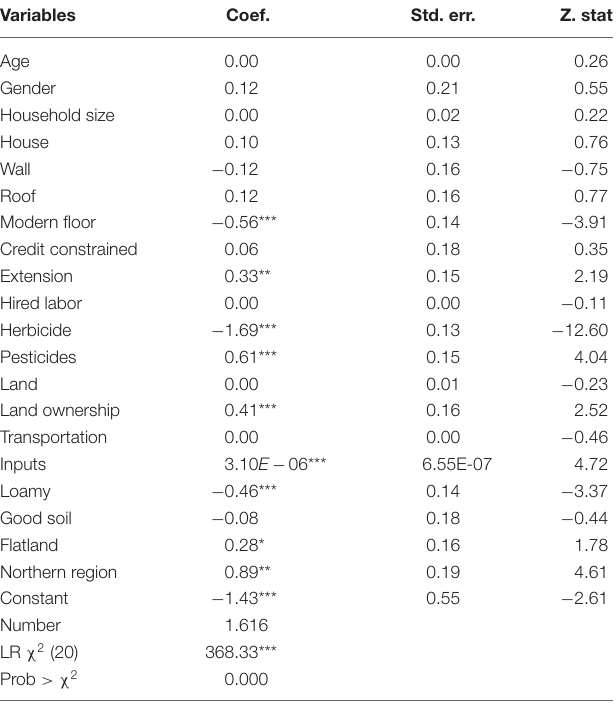
TABLE 3 | Determinants of adoption of organic fertilizers.